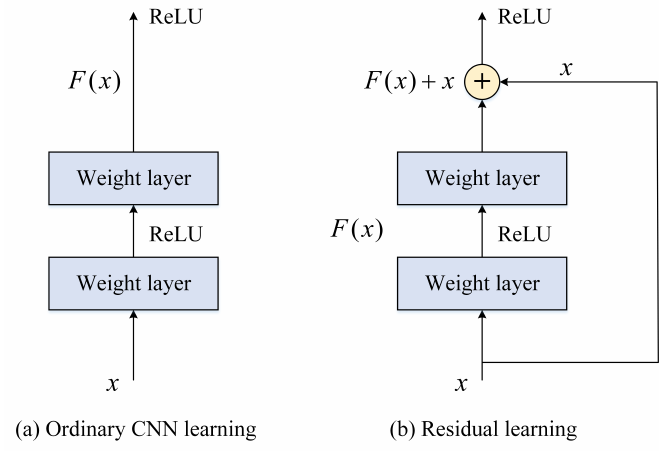
Figure 15. Comparison of ordinary CNN learning and residual